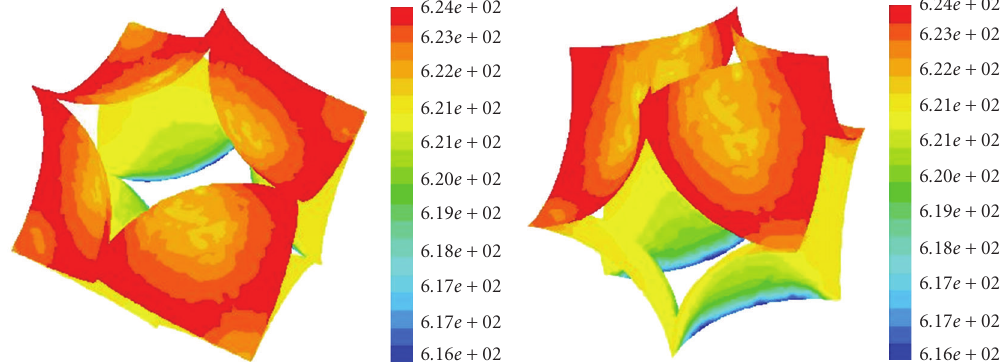
Figure 6: Two views of the wall temperature distribution (in Kelvin degrees) for SC cell “new1” (Steady State—Average Channel).